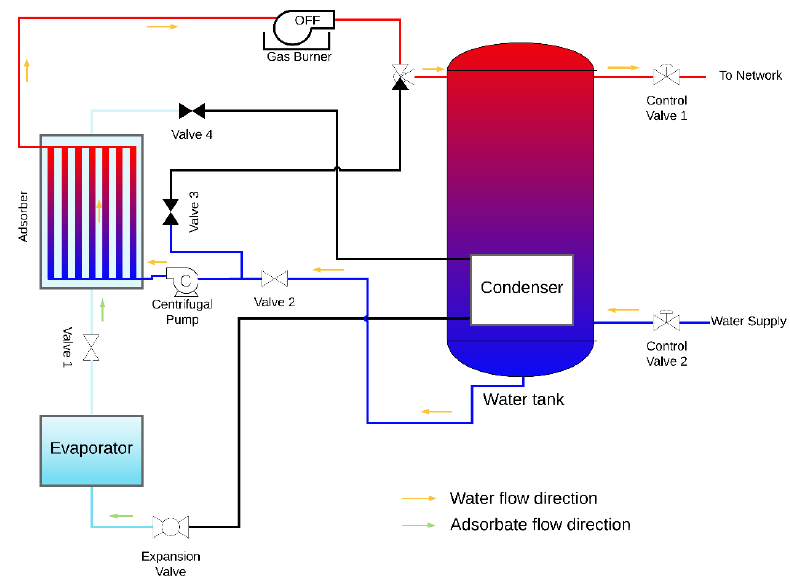
Figure 11. AHP system during the adsorption phase.